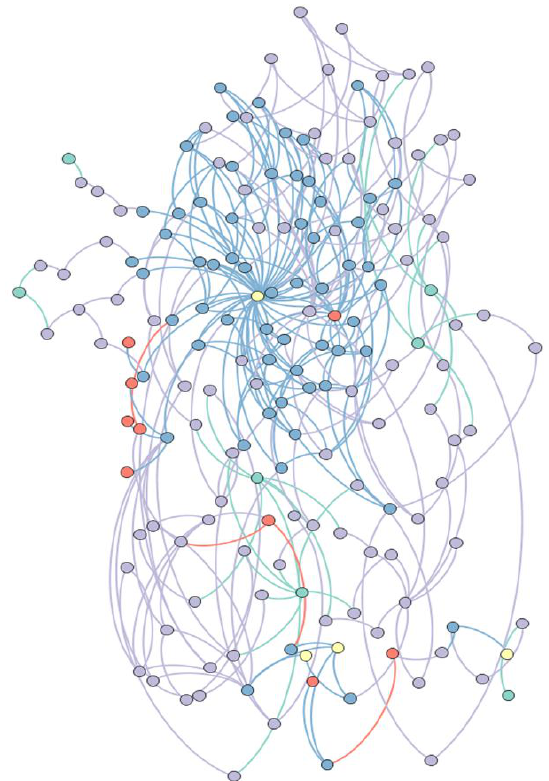
Figure 2. Abstract representation of the bioconversion network used in this study. Yellow nodes correspond to biofuel products, orange nodes correspond to byproducts/intermediates, teal nodes correspond to biomass feedstocks, purple nodes correspond to initial/pretreatment technologies, and blue nodes correspond to final upgrading